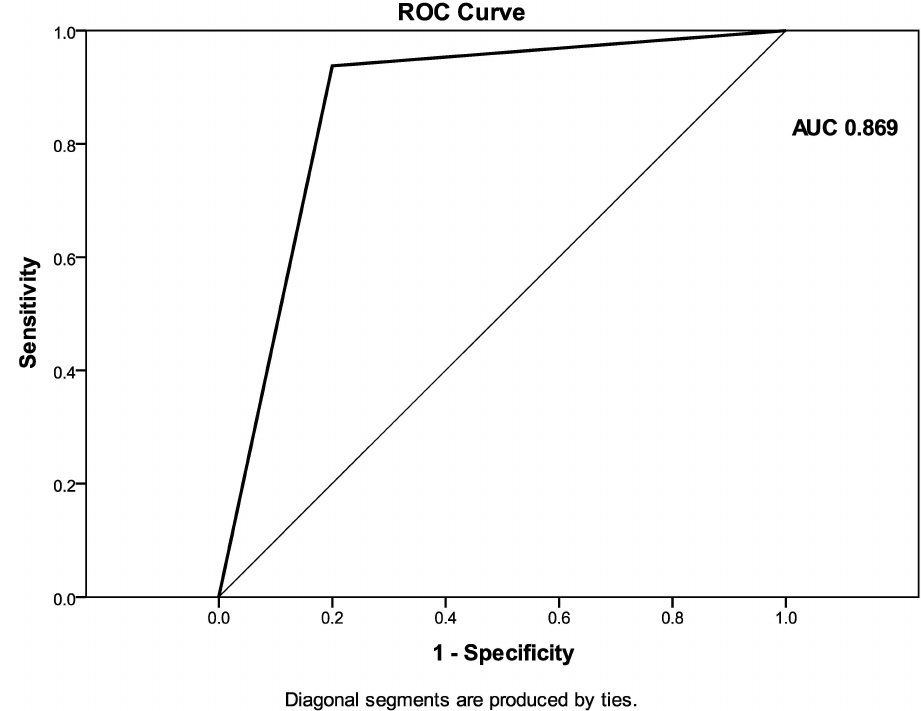
Figure 7. The ROC curve of multivariate regression model with two independent predictors of HR GIST (Probability (0–1; cut-off 0.5) = 0.437 × shape (2-irregular/1-regular) + 0.499 × EFDV (1-present/0-absent)–0.331). AUC = 0.869